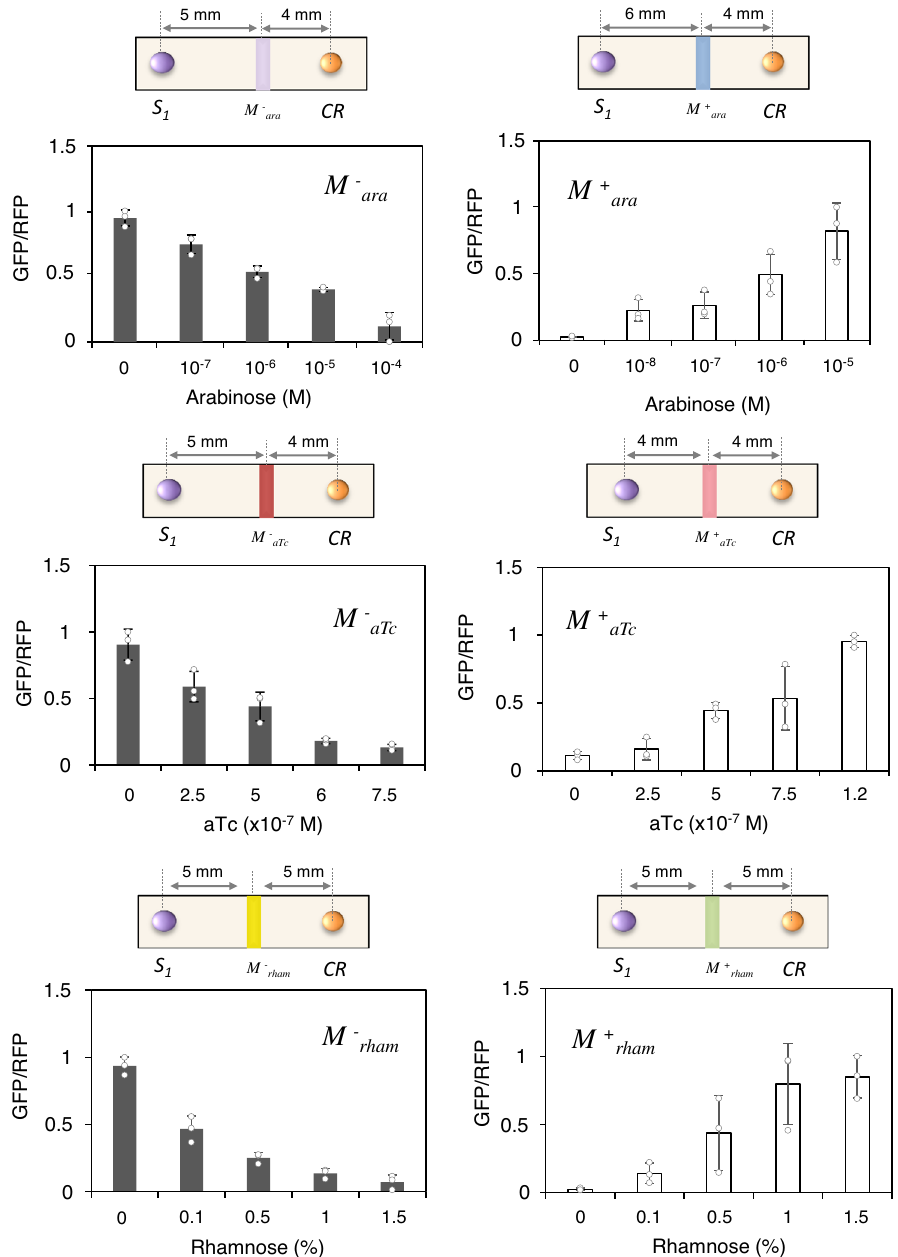
Fig. 2 Relationship between input and output in transistor-like circuits. Output modulation in response to different input concentrations. Modulatory elements M − (black bars) and M + (white bars) cells respond to the external inputs, arabinose (M + ara /M − ara ), aTc (M + aTc /M − aTc ) and rhamnose (M + rham /M − rham ). S 1 cells produce AHL constitutively. GFP levels are normalized by RFP, which correlates with cell population. CR are the reporter cells. Error bars are the standard deviation (SD) of three independent experiments. Data are presented as mean values±SD. Source data are provided as a Source Data fi